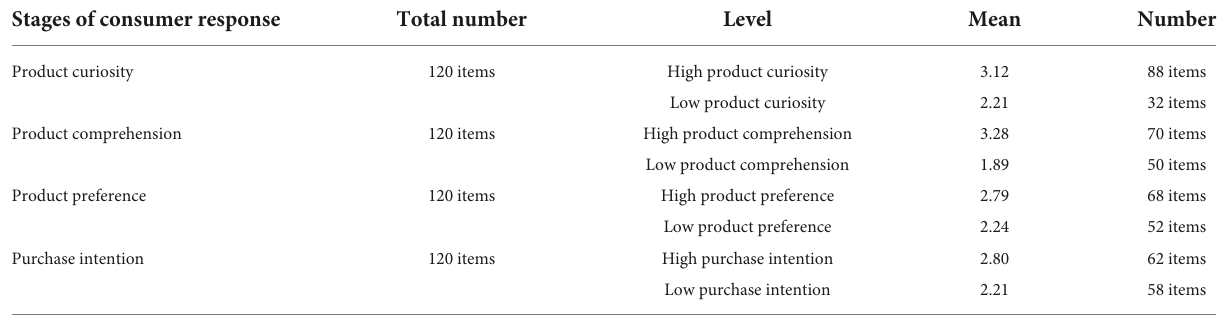
TABLE 1 Mean scores and number of stimuli for high/low levels of internal consumer responses. Stages of consumer response